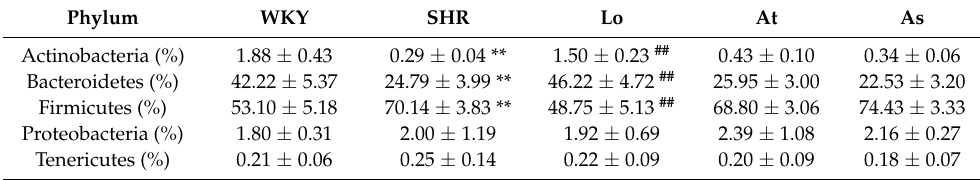
The data are presented as the mean ± SD, n = 6. ** p < 0.01 vs. WKY; ## p < 0.01 vs. untreated